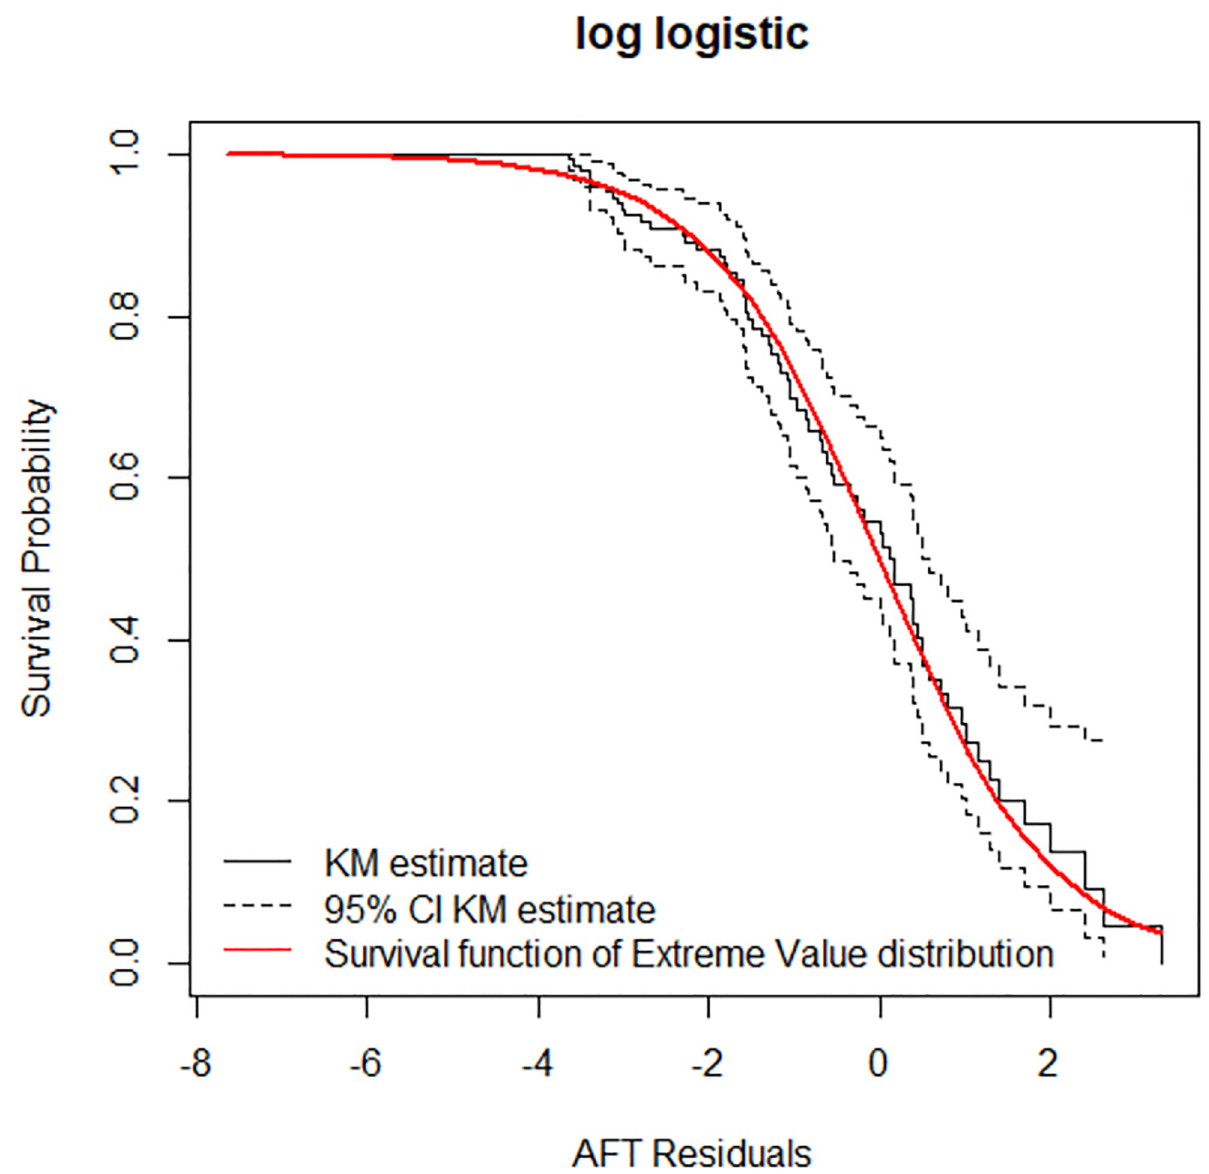
Fig 5. Estimated cumulative hazard plot of the Cox-Snell residuals for the log-logistic baseline distribution, LPAC,